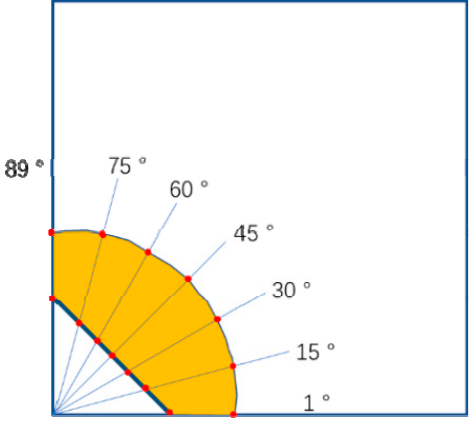
Figure 2. Schematic diagram of the seven-point methodology used for measuring the actual crack length. The red dots indicate the measurement points.